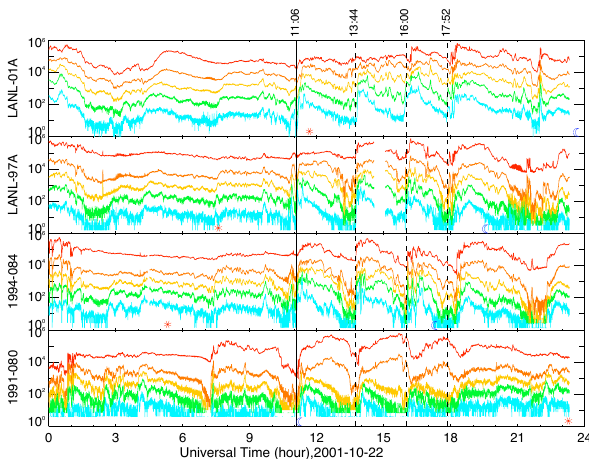
Fig. 5. Plot of LANL SOPA proton data for the sawtooth event on 22 October 2001.The vertical lines illustrate the onset times of the individual